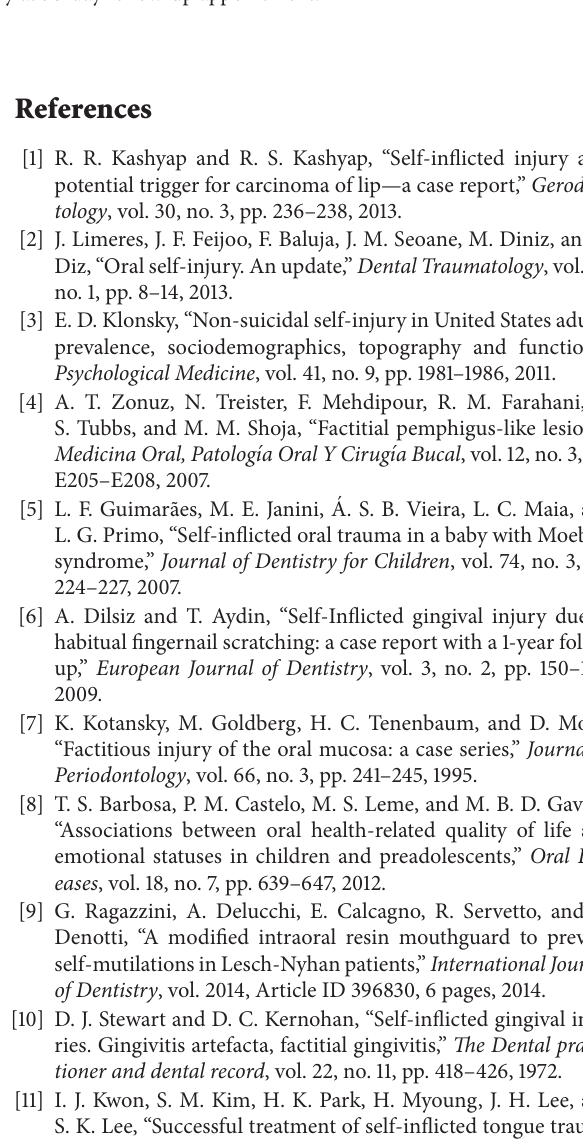
Figure 5: The clinical aspect of the boy at 30-day follow-up appointment.